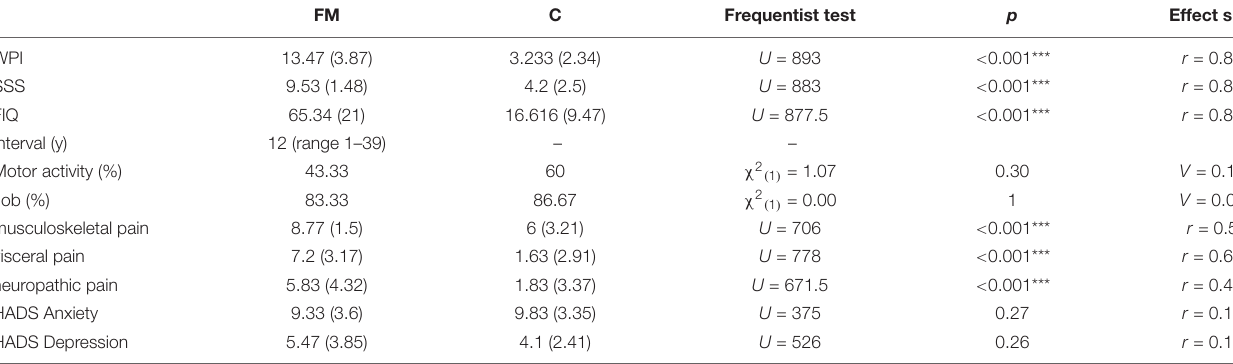
TABLE 1 | Results of the clinical assessment of the two groups.